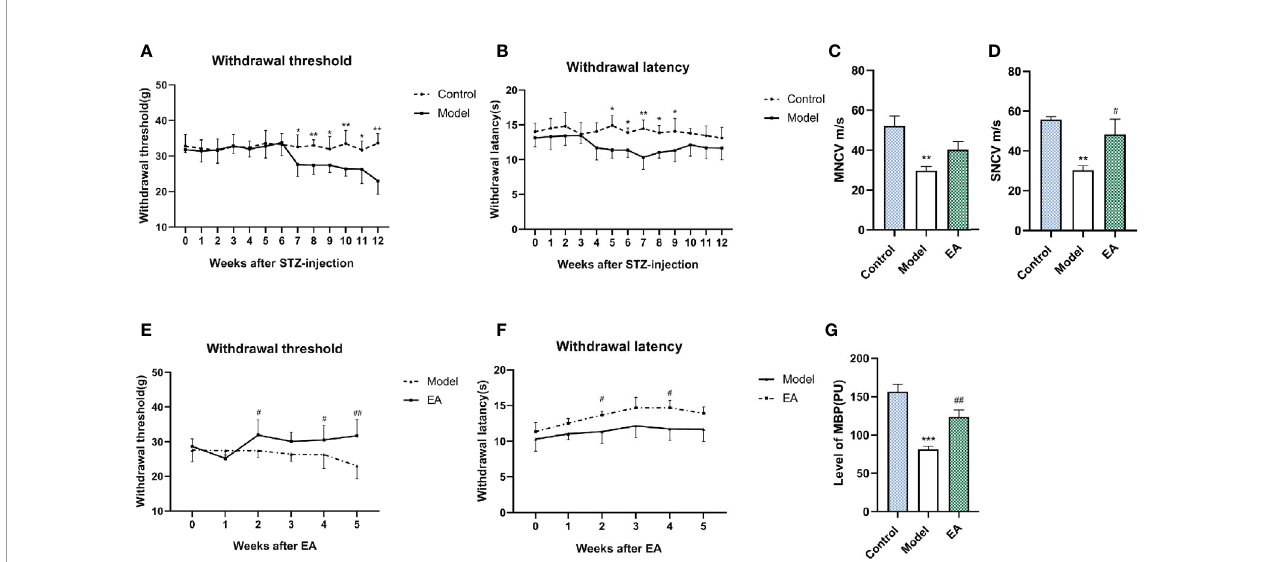
FIGURE 2 | Effect of EA on withdrawal threshold, withdrawal latency, nerve conduction velocity, and microcirculatory blood perfusion. Withdrawal threshold (A) and latency (B) were evaluated weekly after STZ injection and improved signi fi cantly after EA treatment compared to the control group (E, F) (n = 6, *p < 0.05, **p < 0.01, # p < 0.05, ## p < 0.01). Motor nerve conduction (MNCV) (C) and sensory conduction velocity (SNCV) (D) in the control group, the model group, and the EA group (n=4, **p < 0.01, # p < 0.05). MBP (G) in the control group, the model group, and the EA group (n = 6, ***p < 0.001, ## p <